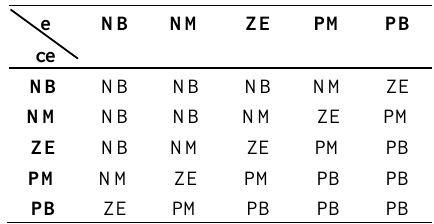
Table I. Fuzzy Rule